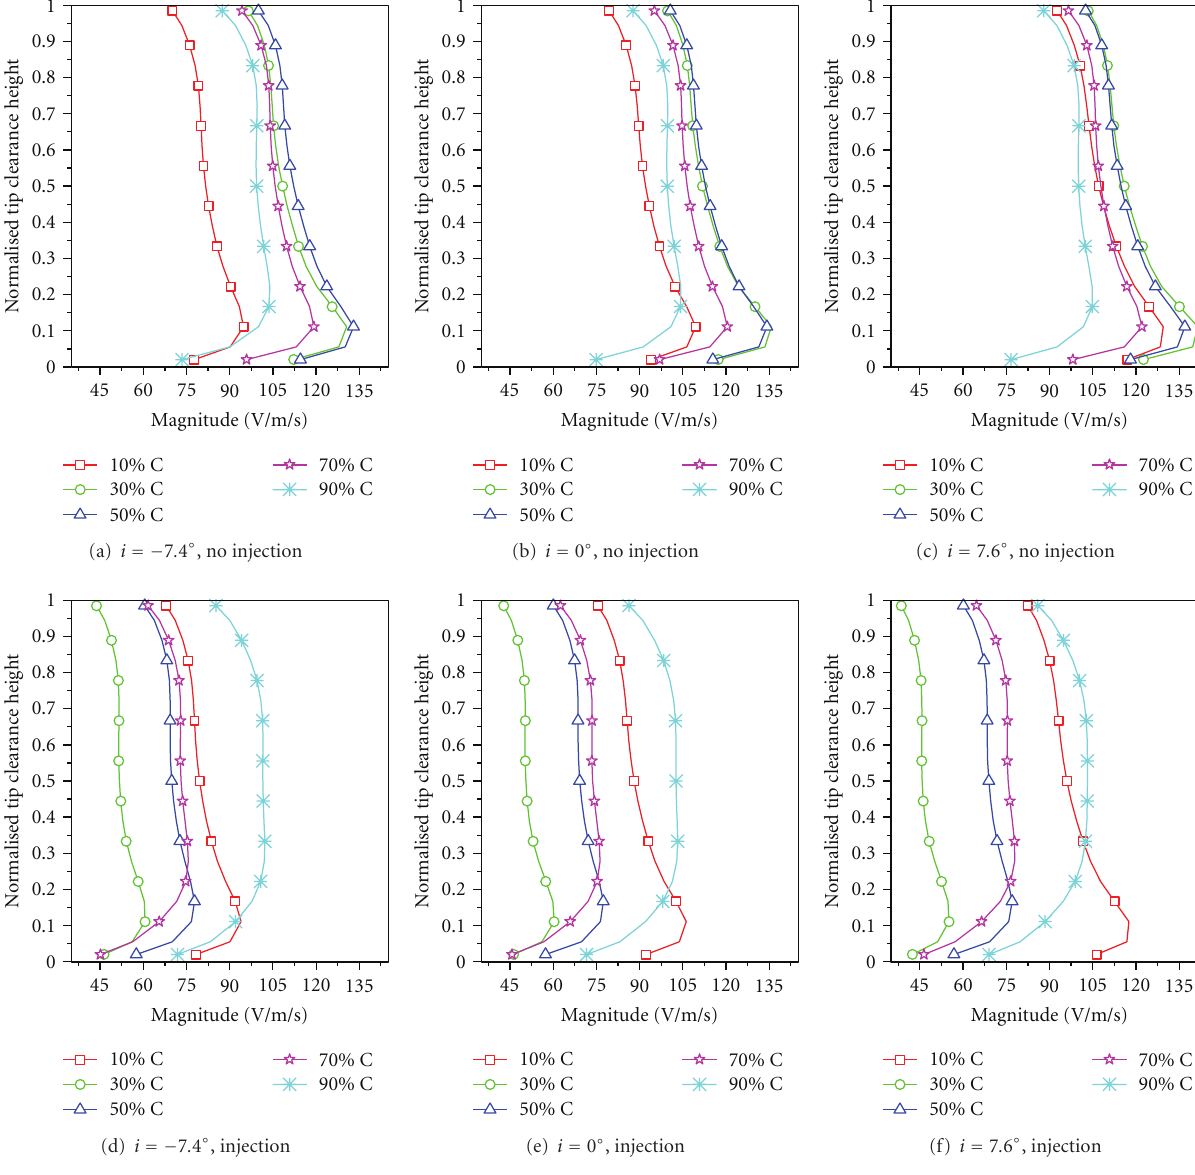
Figure 8: Distribution of velocity profiles at the tip clearance